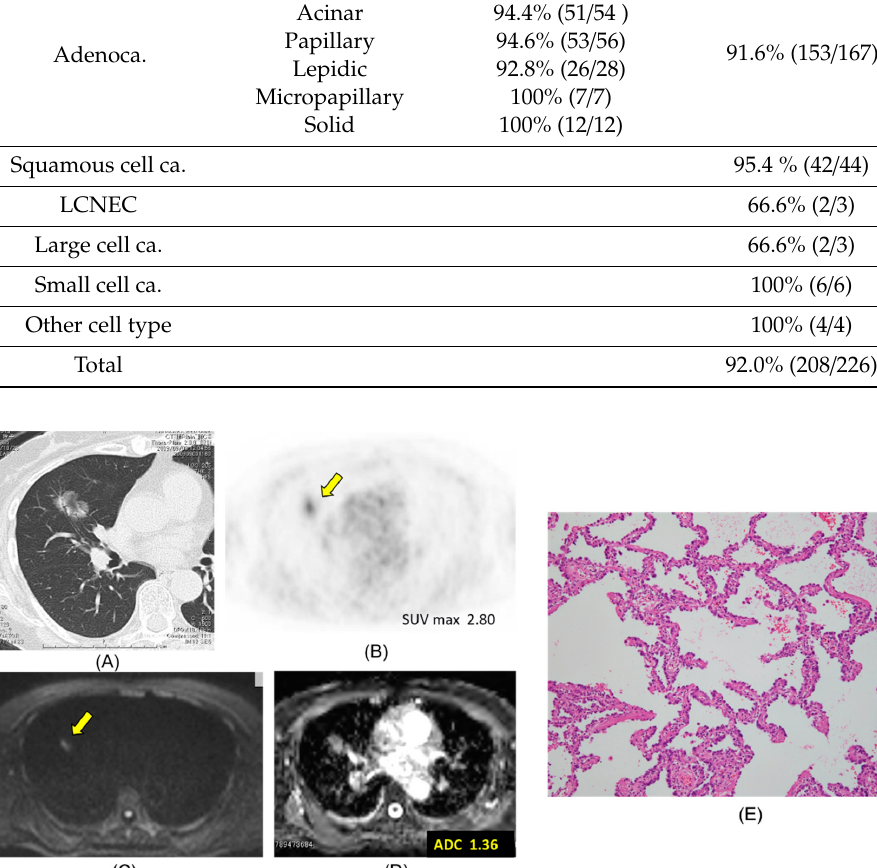
Table 1. Sensitivity of diffusion-weighted imaging (DWI) for lung cancer.